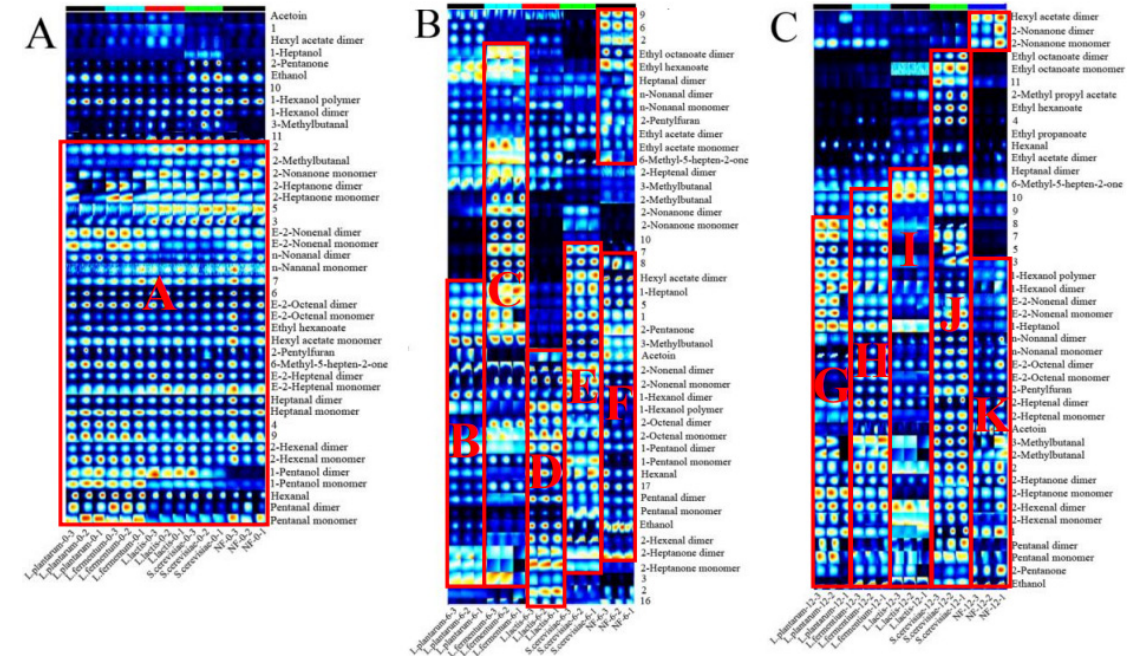
Figure 5. The qualitative analysis topographic plots ( A – C ) of fresh fermented rice noodles by HS- GC-IMS. L. plantarum represents adding Lactobacillus plantarum ; L. fermentum represents adding Lactobacillus fermentum ; L. lactis represents adding Lactococcus lactis ; S. cerevisiae represents adding Saccharomyces cerevisiae and NF represents fermented